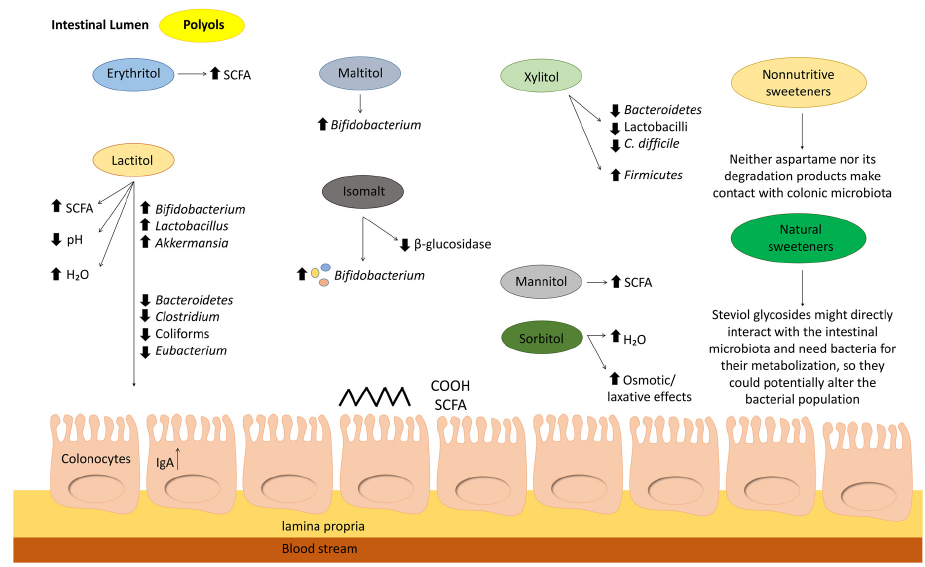
Figure 1. Schematic representation of sweeteners’ effects on the gut microbiota. Abbreviations. IgA, Immunoglobulin A; N/A, not available information; SCFA, short-chain fatty acids.